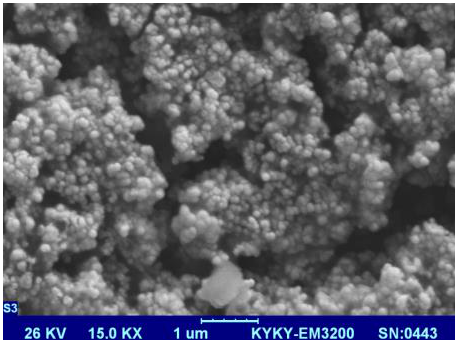
Figure 5. Nanocomposite ceramic coating with heat treatment at 450°C, at 15000 times magnifications